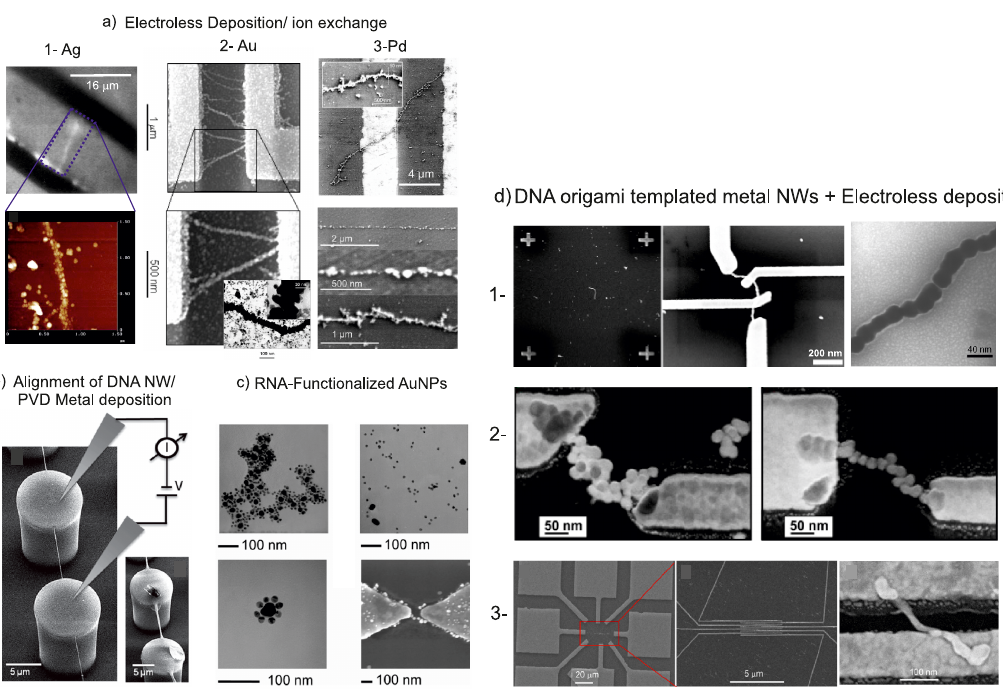
Figure 2. ( a ) images of nanowires made from Ag, taken with permission from [12], Au, taken with permission from [18], and Pd, taken with permission from [11]; ( b ) Scanning electron microscopy (SEM) image of suspended DNA nanowires metalized by evaporation of Au taken with permission from [20]. Thin (left) and thick (right) DNA nanowires NWs are bridging between two nanopillars. The scheme illustrating the electrical measurements setup which were performed by using micromanipulator on top of the nanopillars; ( c ) transmission electron microscopy (TEM/)SEM images of clusters of AuNPs bound together via RNA functionalization and contacted by electron beam lithography (EBL) (bottom right image) taken with permission from [41]; ( d ) various DNA templated Au nanowires contacted by EBL. (1) DNA molds filled with Au taken with permission from [38]; (2) DNA nanotubes metalized using functionalized AuNPs as seeds, images taken with permission from [36]; (3) Nanowires